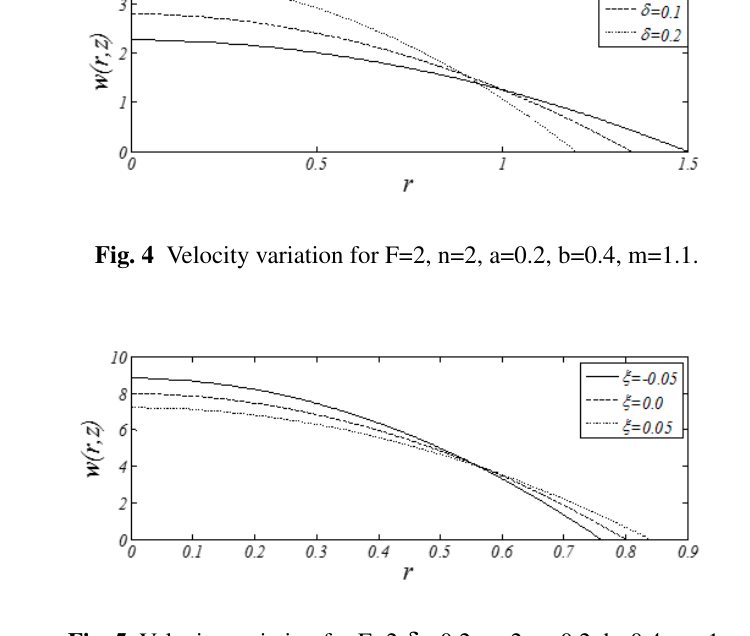
Fig. 5 Velocity variation for F=2, δ =0.2, n=2, a=0.2, b=0.4,